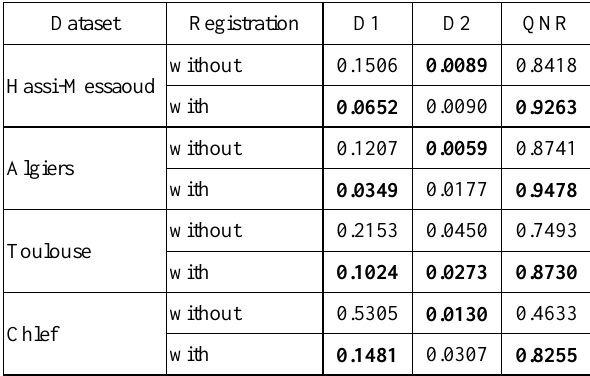
Table 1. Resulting QNR score for the fusion with and without registration.